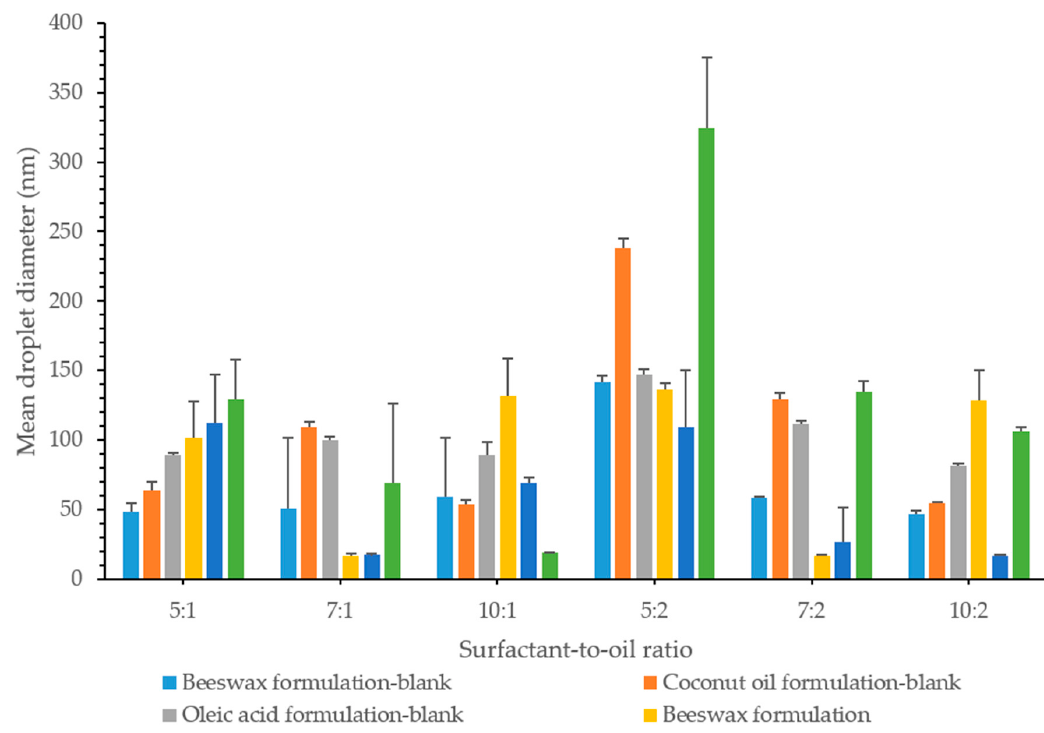
Figure 5. Mean droplet size of blank and drug formulations showing the effect of oil composition, oil type, and the effect of drug.